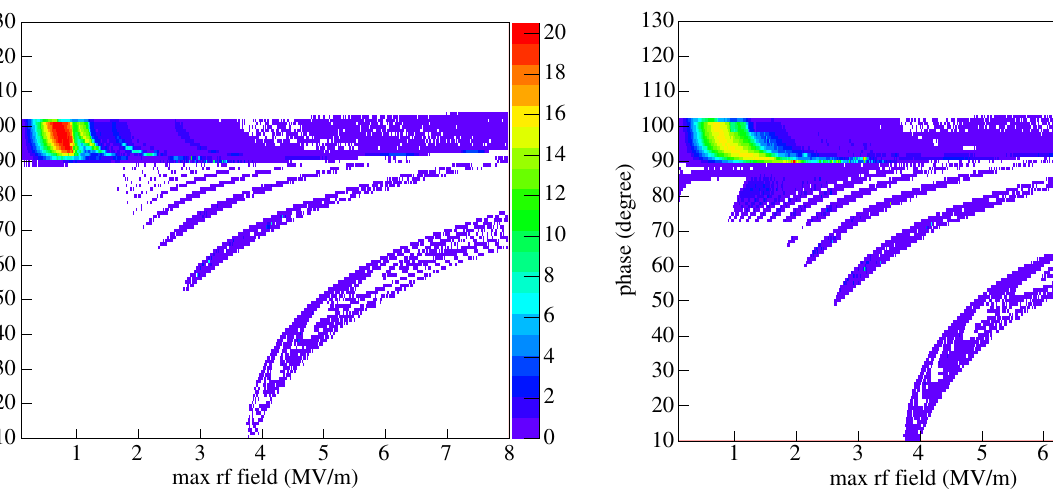
FIG. 17. (Color) Electron multiplication factor as a function of the maximum rf field and the emission phase for main and bucking solenoid currents of 400 and 30.5 A, respectively. Primary and secondary electrons were tracked for 100 rf cycles. The zone of high multiplication factor is larger than in Fig. 16. The multiplication factor is especially high at rf phases near 90 (cid:2) , where the field emission is highest. The white area shows no multipacting condition.